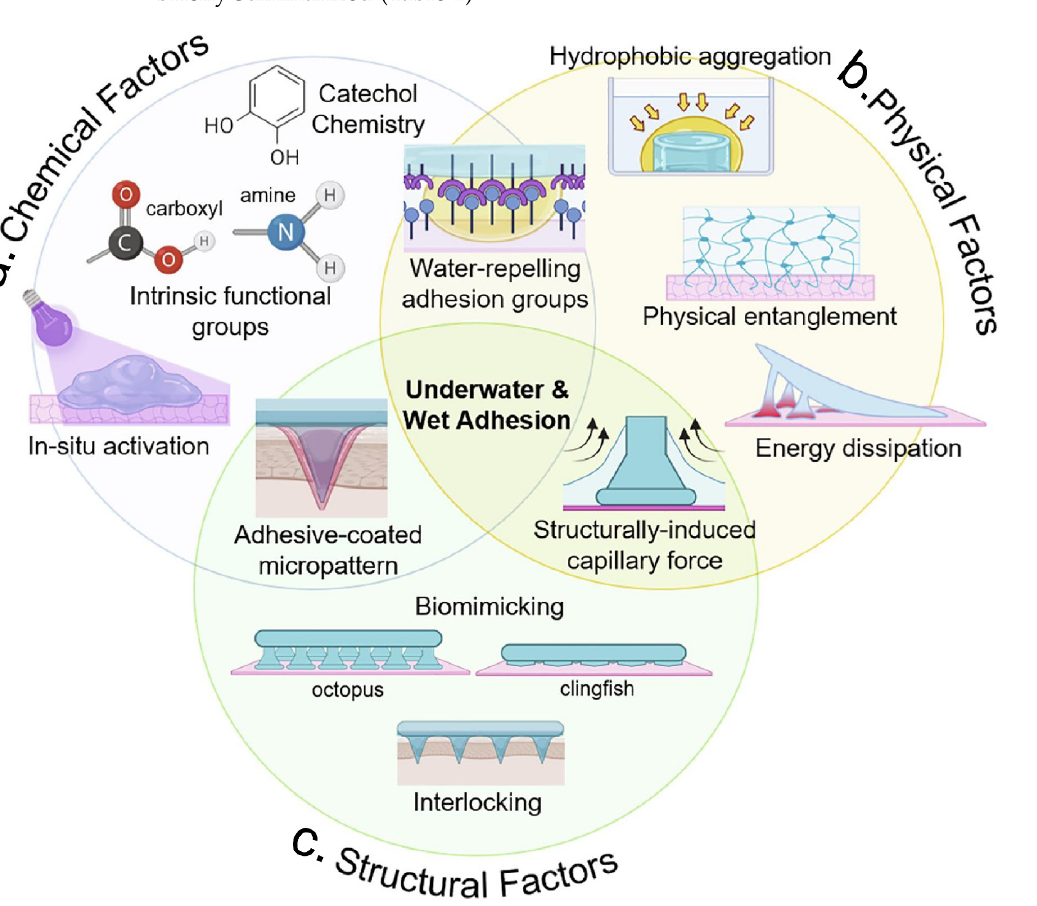
Figure 4. The practical application of hydrogels in wet adhesion involves complex interactions that can be divided into three main categories: chemical, physical, and bionic structural factors. ( a ) Chemical factors, such as catechol chemistry, in situ activation, and reactions of intrinsic groups of the material. ( b ) Physical factors, such as hydrophobic aggregation, physical entanglement, and en- ergy dissipation. ( c ) Biomimetic structural factors, such as micro-patterning and capillary forces. Figure modified from [43] with permission.